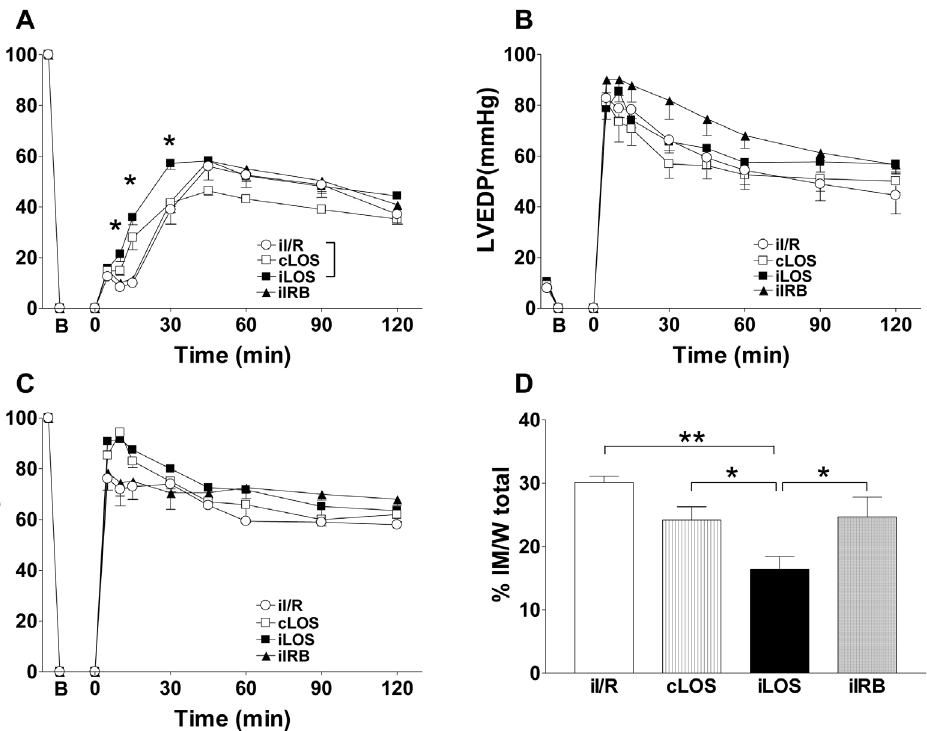
Figure 2. Intermittent losartan post-ischemic administration improves systolic function and reduces infarct mass extent. Hearts exposed to ischemia/reperfusion (iI/R group) were compared to hearts exposed to intermittent (iLOS group) or continuous (cLOS) losartan, as well as intermittent irbesartan (iIRB) administration. In each panel, B corresponds to the beginning of ischemia and time 0 corresponds to the beginning of reperfusion. A. Systolic function. Percent variation of developed left ventricular pressure (dLVP) with respect to baseline level for each group, during the 120 min reperfusion following 30 min global ischemia. B. Diastolic function. Left ventricular end diastolic pressure (LVEDP, mmHg) during the 120 min reperfusion following 30 min of global ischemia. C. Percent variation of coronary flow during the 120 min reperfusion following 30 min of global ischemia. D. Infarct mass. The amount of necrotic tissue is expressed as a percent of the left ventricle mass. Two-way repeated measures ANOVA was employed to determine the main effect of time, group and time by group interaction. A one-factor ANOVA followed by Bonferroni correction analysis was performed between different groups within the same time-point. * p , 0.05. ** p , 0.01.